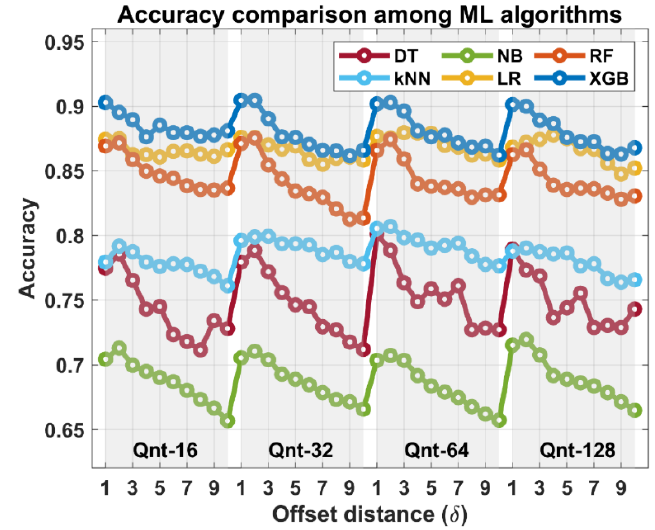
Figure 4. Accuracy comparison among the six machine learning algorithms. Qnt stands for quanti- zation and the following number indicates the quantization level. For example, Qnt-32 means that the preprocessed ECG data were quantized with 32 levels. Each quantization level is represented in shades.